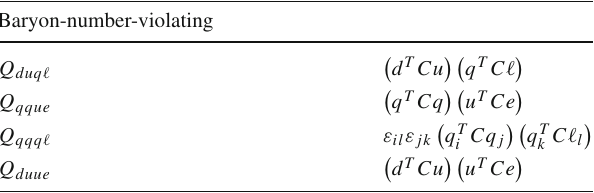
Table 4 Baryon-number-violating operators. We use C to denote the Dirac charge conjugation matrix Baryon-number-violating